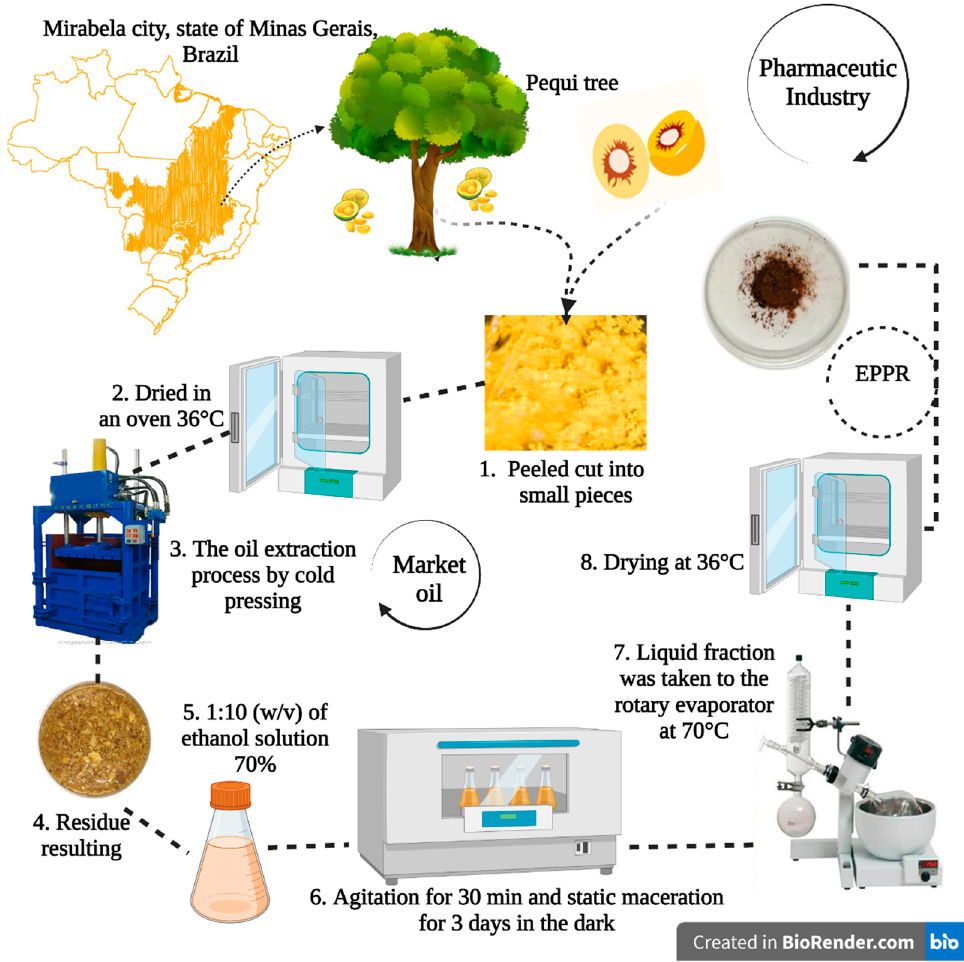
Figure 9. Preparation of the hydroethanolic extract of pequi pulp residue (EPPR).